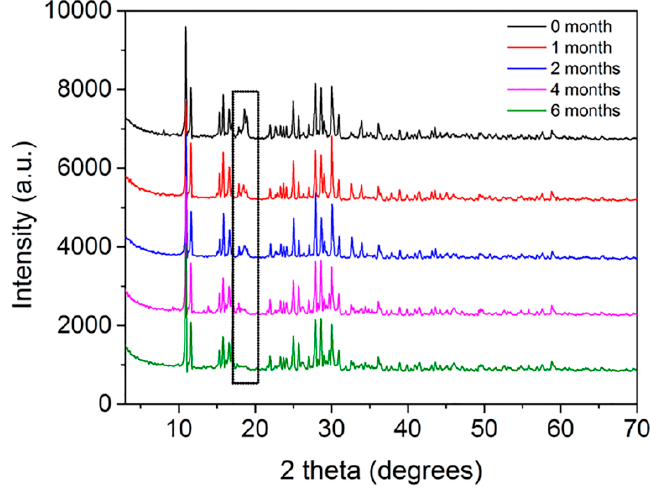
ff erent degradation